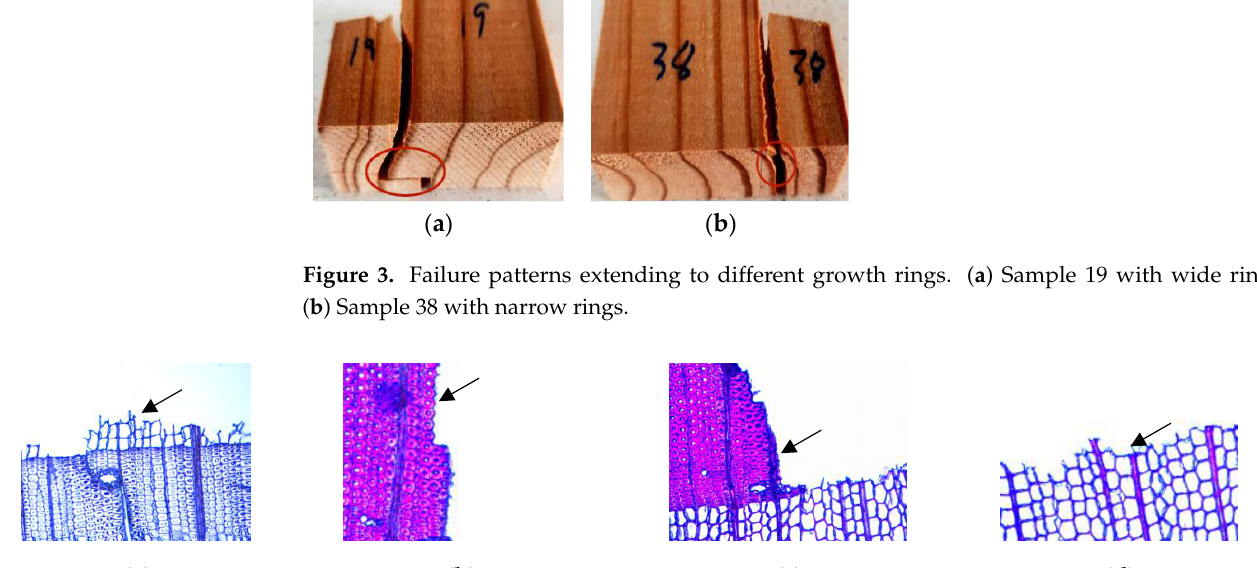
Figure 2. Failure mode of the shear failure of 40 samples.